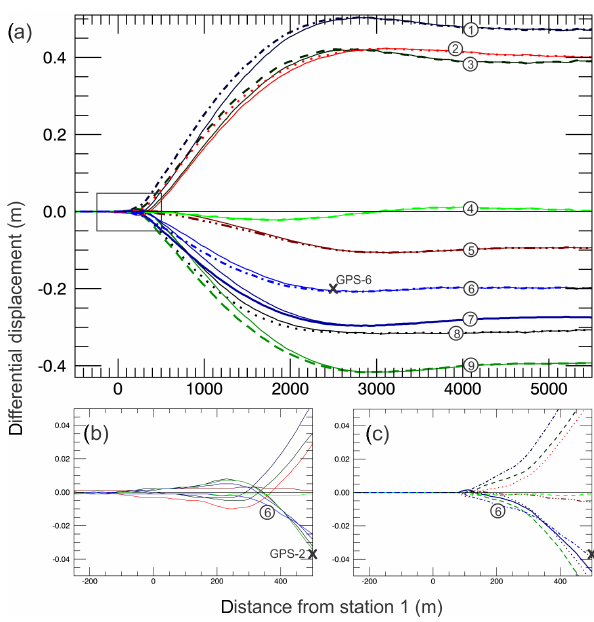
Figure 5. (a) Tidal flexure along the validation profile for nine dif- ferent combinations of interferograms without surface strain cor- rection (thinner full lines) and with elastic strain correction applied (dashed lines). The close-up shows the area near the grounding line for (b) the uncorrected and (c) the corrected displacement. The numbers in (a) refer to the differential interferograms in Table 1. Symbols ( x ) show the GPS validation measurements for profile